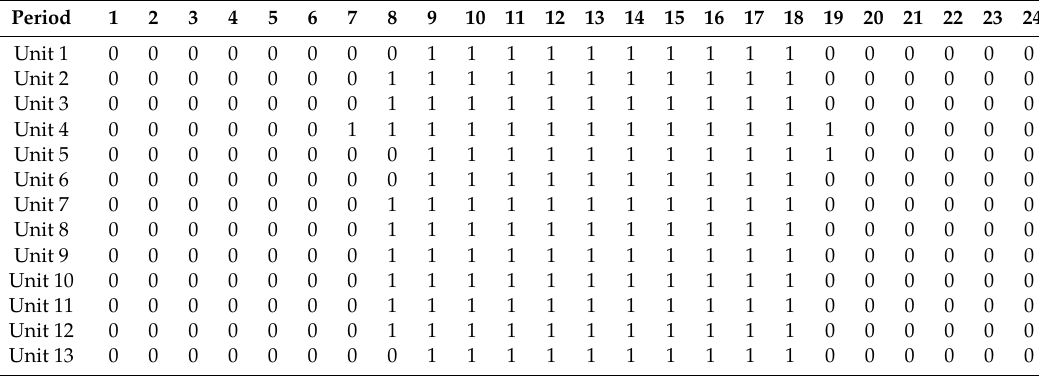
Table 5. Comparison of the original load and the optimized load obtained by MILP in Case 2.